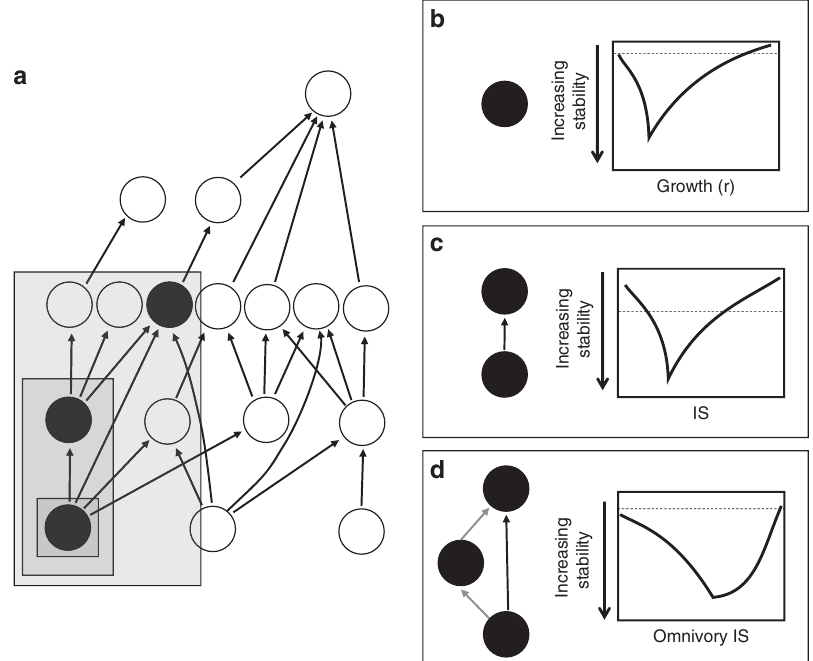
Figure 1 | Decomposition of food webs into stability building blocks. Modular theory attempts to decompose complex food webs like in a by looking at the stability patterns as interaction strength (IS) is changed of the simpler, sub-web (filled circles), building blocks (grey boxes). A general finding from modular theory is a stability tradeoff for increasing the flux/growth/interaction strength, where we expect an initial stabilization phase as increased energy leads to increased resilience/stability as populations can respond to perturbations more rapidly. Ultimately this same increased energy begins to lead to overshoot, as the populations respond so rapidly, coupled with a lag, that the return to equilibrium is missed. This behaviour occurs for lagged population models ( b ) consumer-resource interactions ( c ) as well as higher order food web modules such as same chain omnivory ( d